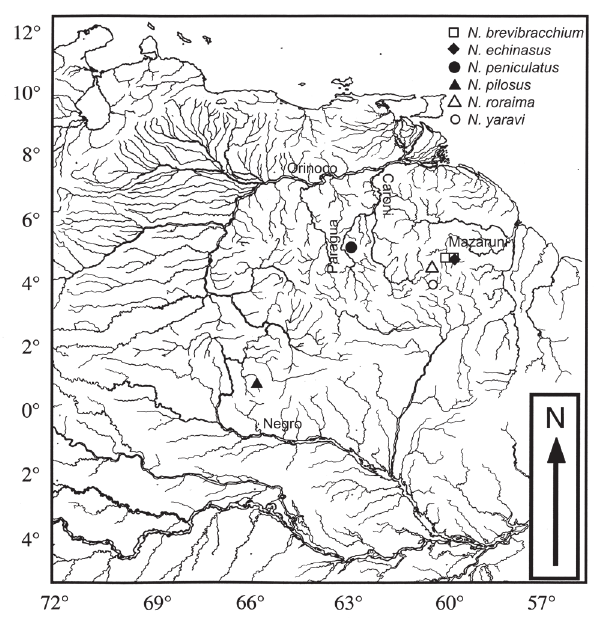
Fig. 1. Distribution of Neblinichthys . Main drainages where the species are located indicated. Symbols may represent multiple localities.